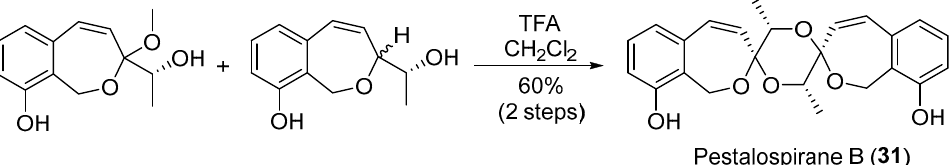
Figure 5. Structures of compounds 27 – 35 .